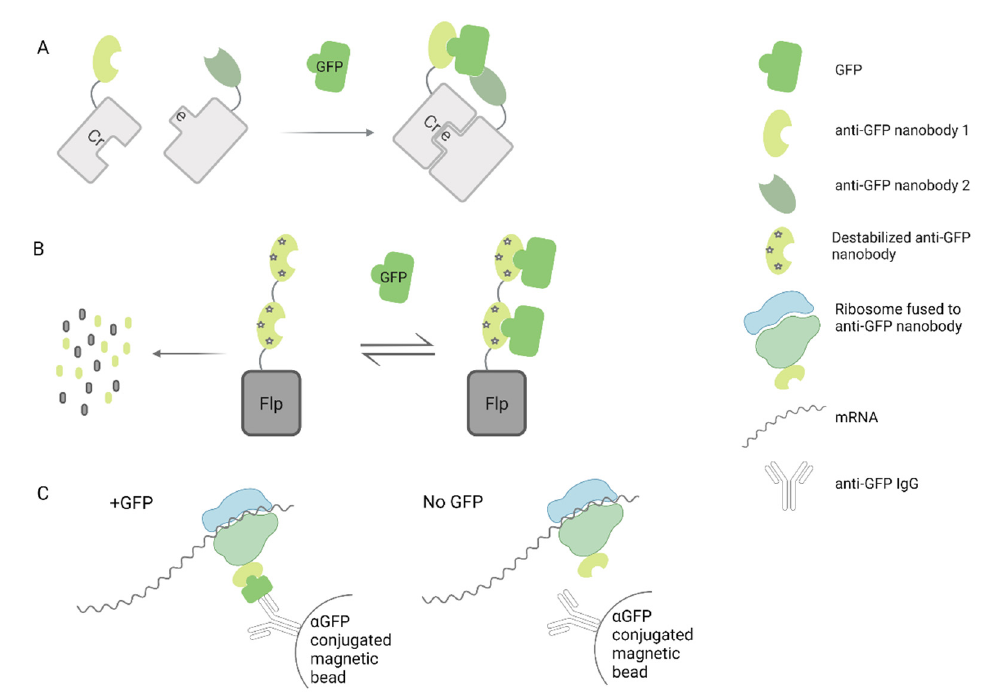
Figure 3. Schematic representation of research approaches using GFP/nanobodies scaffolds delivered by AAV vectors. ( A ) Cre recombinase dependent on GFP system, ( B ) Flp recombinase dependent on GFP system, ( C ) Immunoprecipitation of ribosome complexes dependent on GFP [82] and